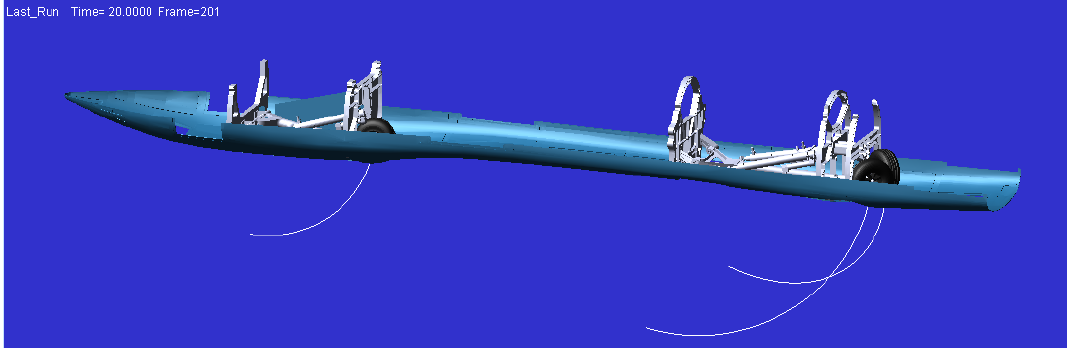
Figure 6. Modelling of aircraft with landing gears in retracted configuration.